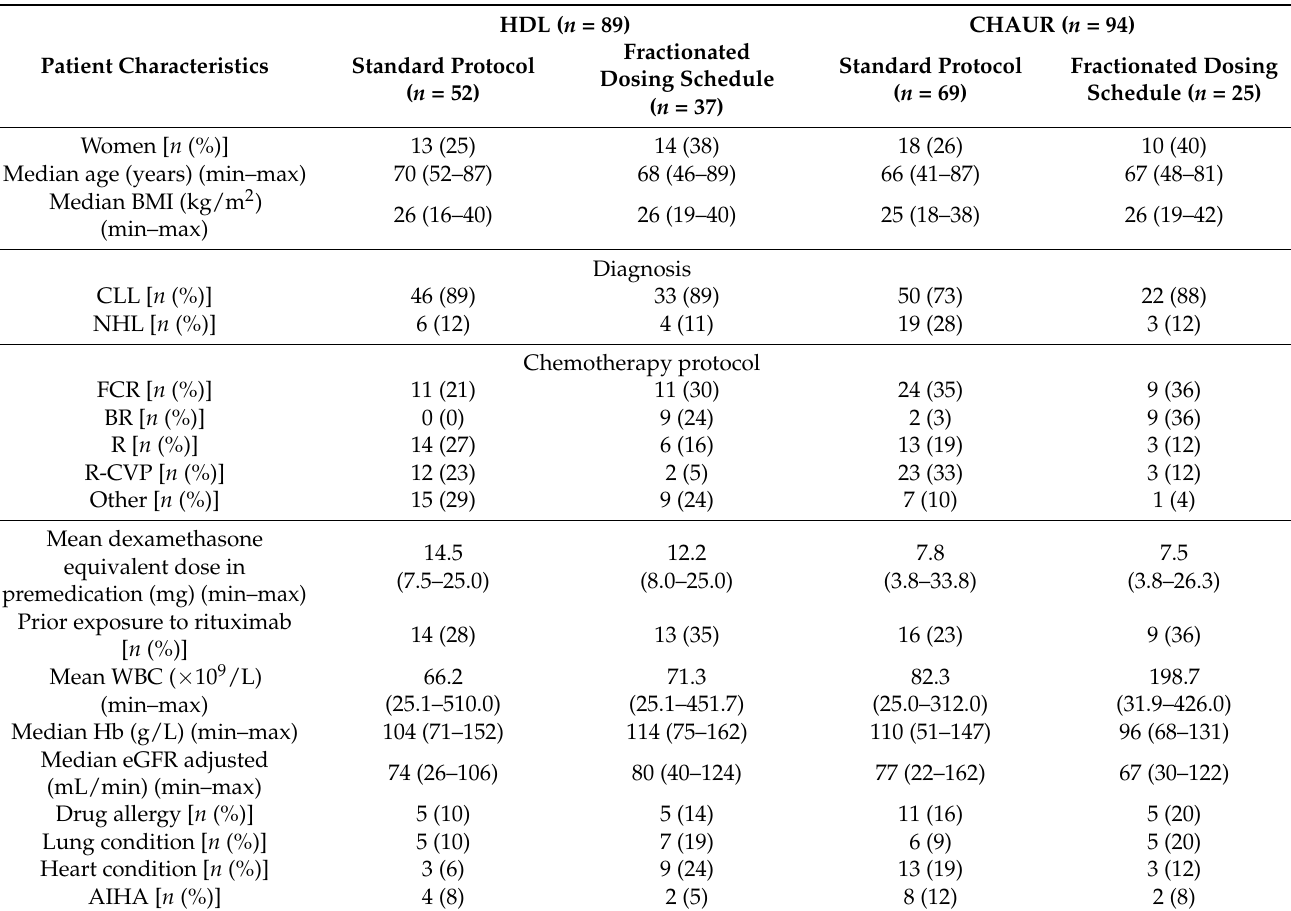
Table 1. Baseline patient